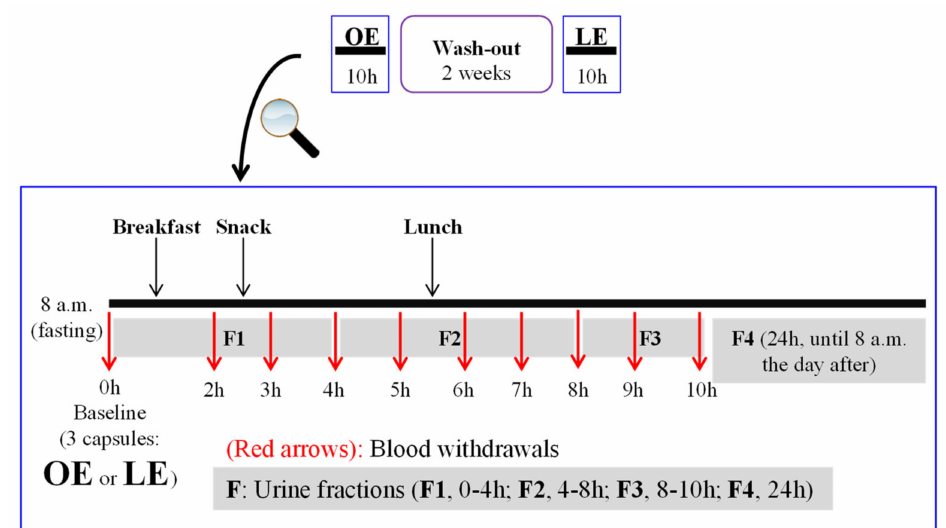
Figure 1. Study design. OE, orange extract; LE, lemon